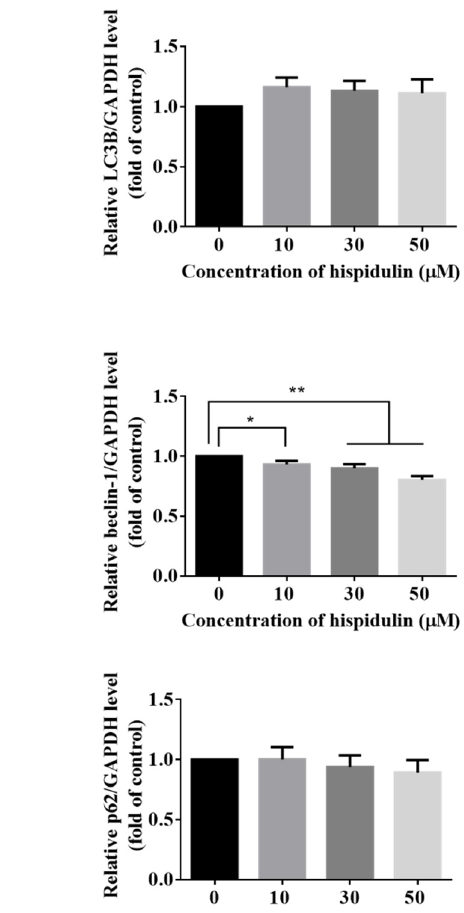
Figure 4. Expression levels of ( A ) cleaved caspase 3, ( B ) cleaved PARP, ( C ) cleaved caspase 8, and ( D ) cleaved caspase 9 in A2058 cells treated with indicated concentration of hispidulin or DMSO (control) for 24 h were examined by Western blot assay. GAPDH was used as an internal control. Data are presented as fold of control and mean ± SE, with * p < 0.05 and ** p < 0.01 compared with the control group (n = 5).